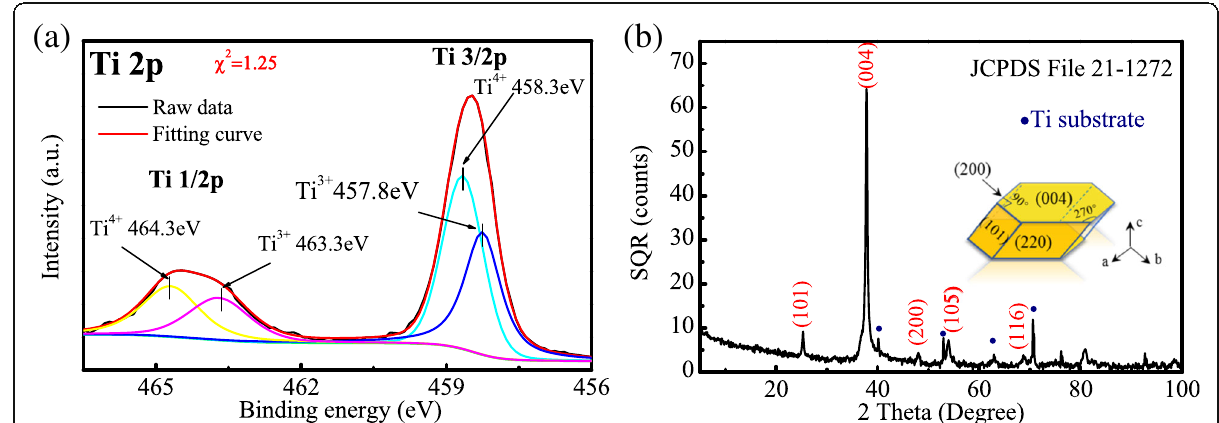
Fig. 3 a Ti 2p XPS spectra of H@TNAs-1. b XRD pattern of H@TNAs-1 and sketch of the plate-like anatase grain with preferred